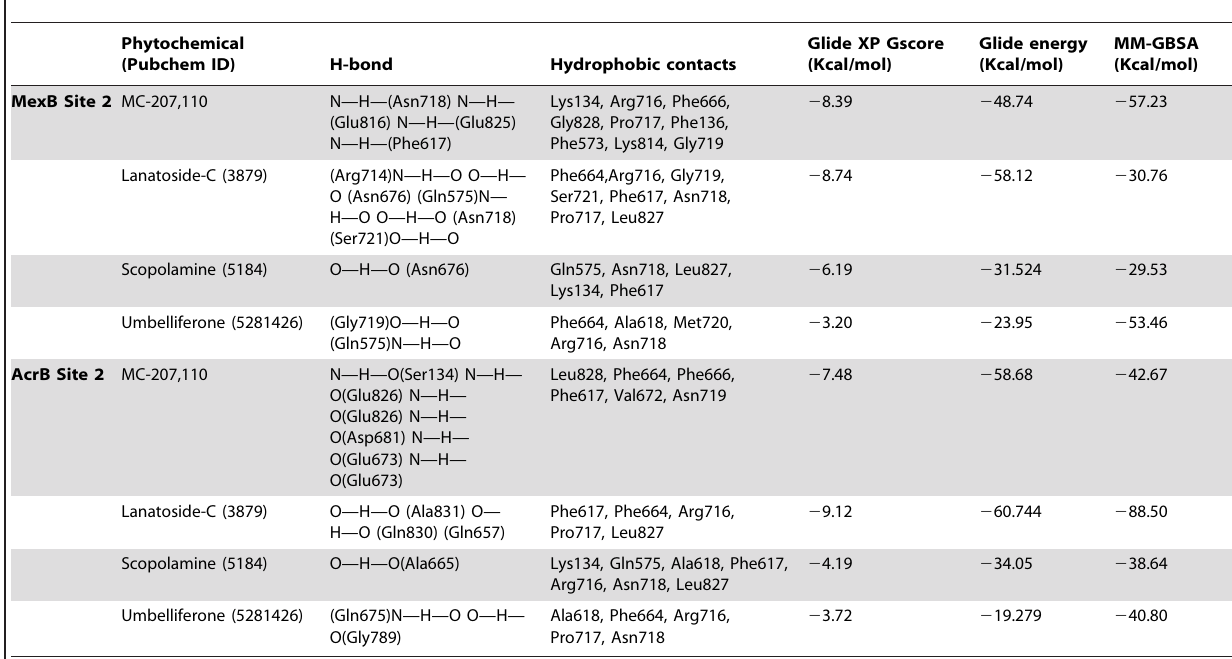
Table 2. Molecular interactions of phytochemicals with the active site residues in the binding site 2 of target proteins, MexB of P. aeruginosa and AcrB of E. coli